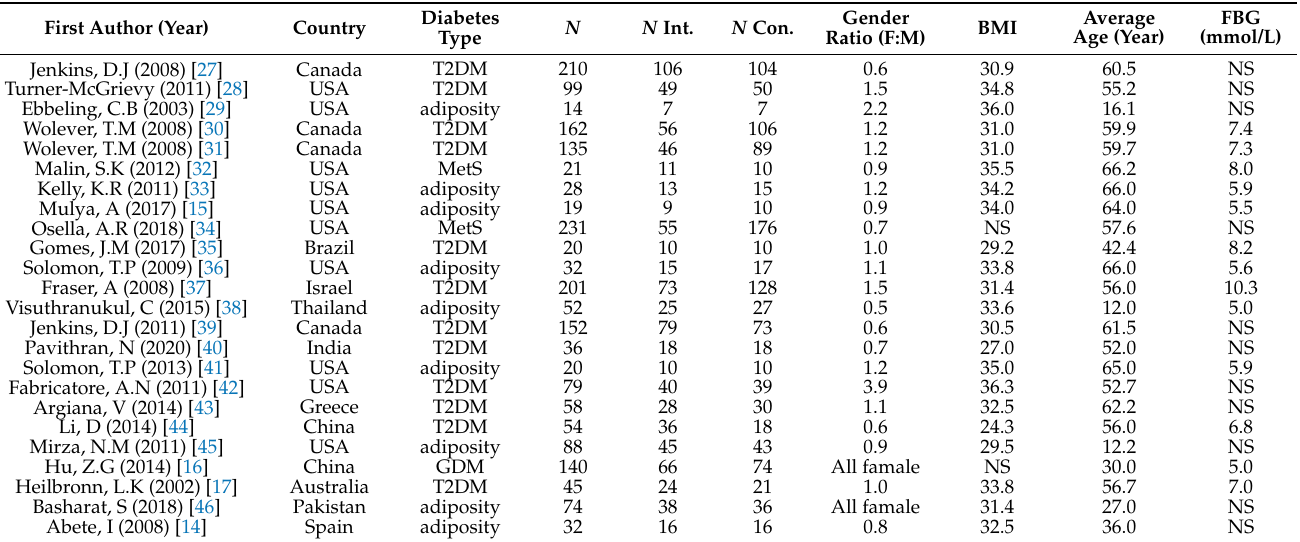
Table 1. Basic characteristics of the included